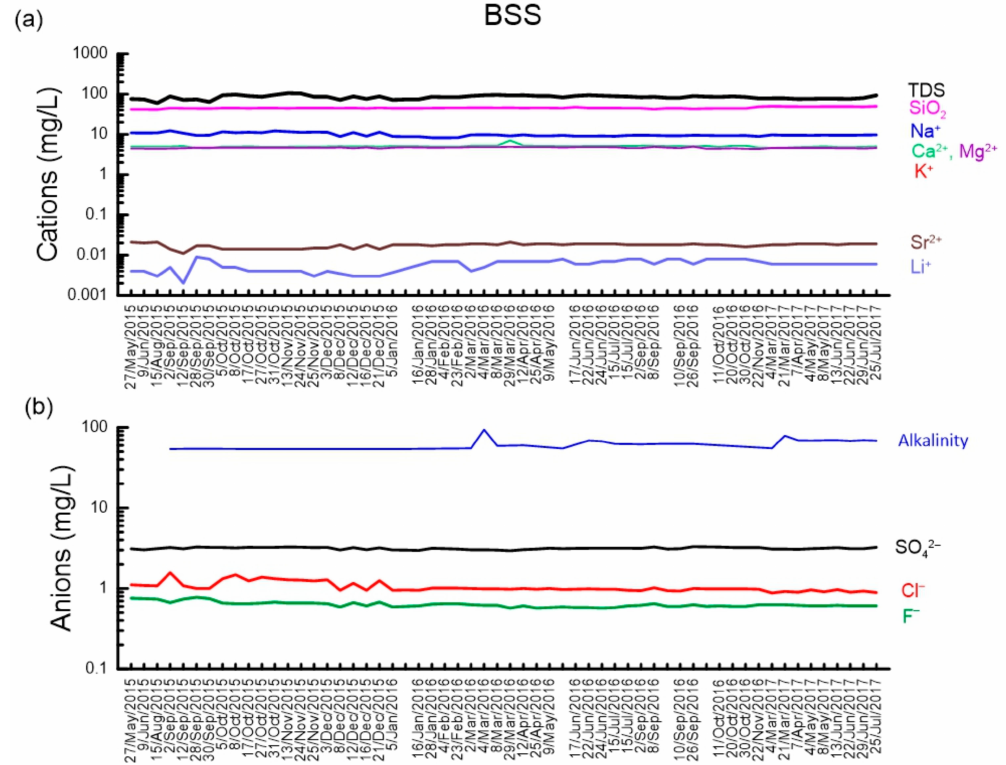
Figure 4. Variation diagram of ( a ) cations, and ( b ) anions in the BSS bottled waters from April 2015 to September